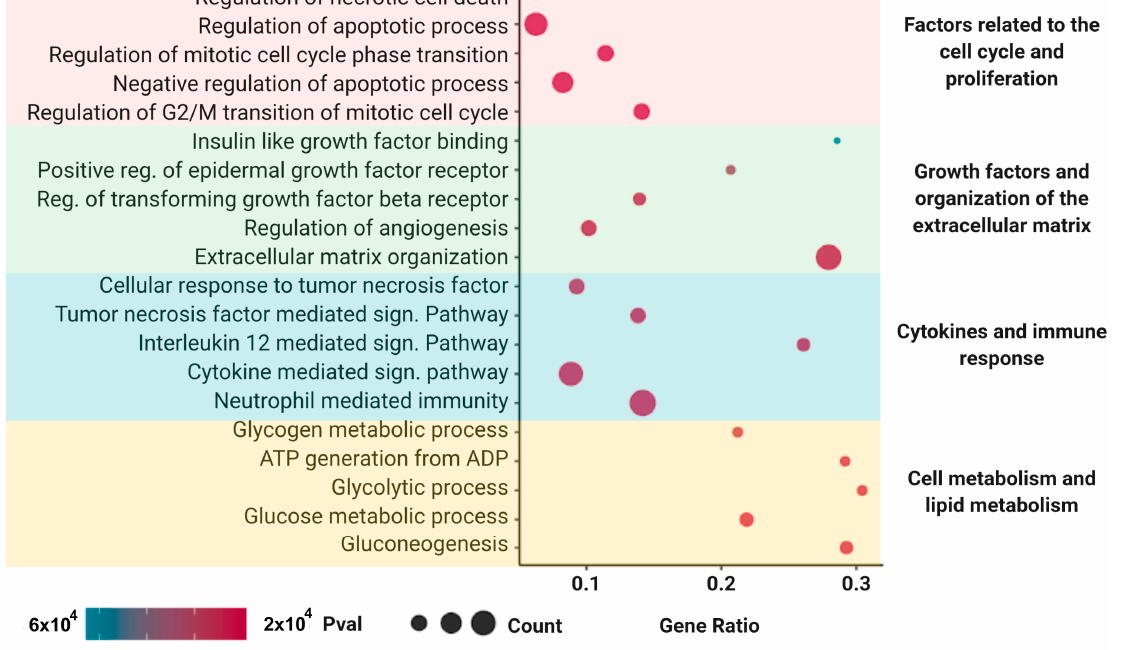
Figure 9. Mass spectrometry and enrichment analysis of the MSC secretome derived from adipose human MSCs. Functional enrichment analysis ( p < 0.05) of the differentially expressed proteins according to the Reactome, Gene Ontology (Molecular Function and Biological Process), KEGG, and Wiki Pathways databases. Enriched functional categories were chosen on the basis of their association with the hepatic regenerative process described in this work. A total of 570 proteins were identified in the MSC secretome. The analysis revealed enrichment in proteins associated with cell cycle control and proliferation, growth factors, and organization of the extracellular matrix, as well to the immune response and lipid metabolism.